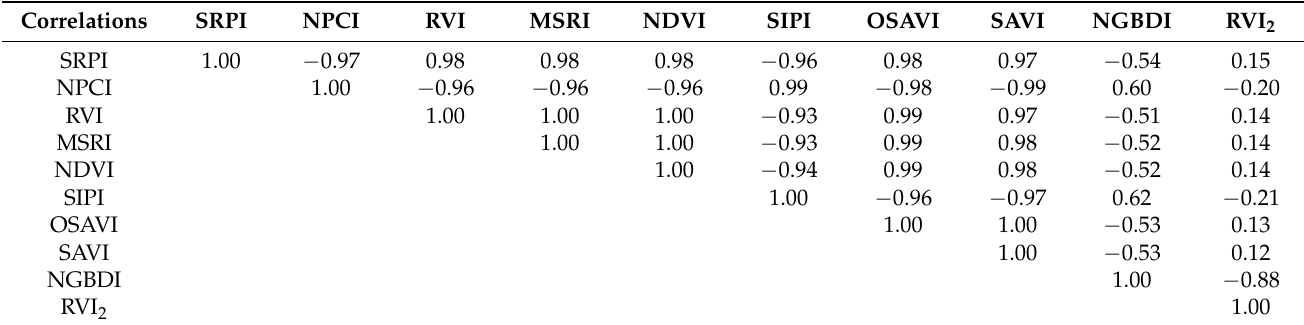
Table 5. Correlations between each